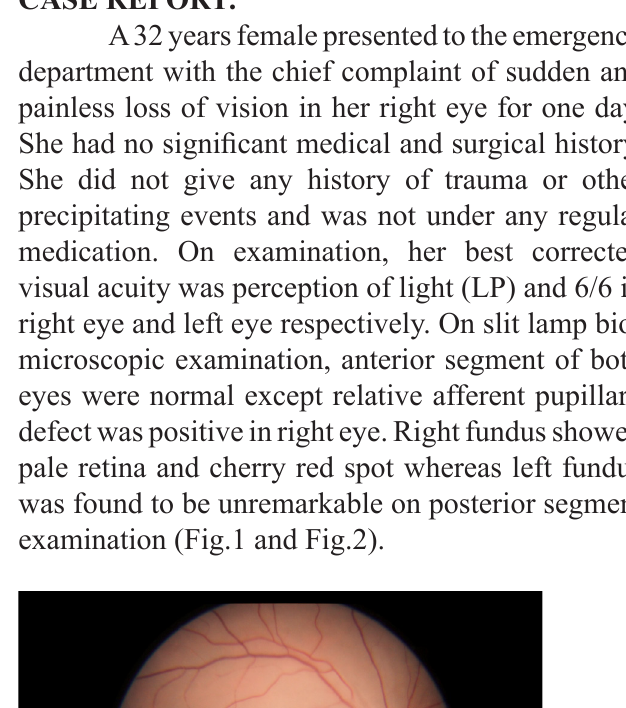
Fig. 3. Echocardiogram of the patient shows large ostium secundum ASD with left to right shunt (yellow arrow) (A), dilated right atrium and right ventricle (B) by a transthoracic